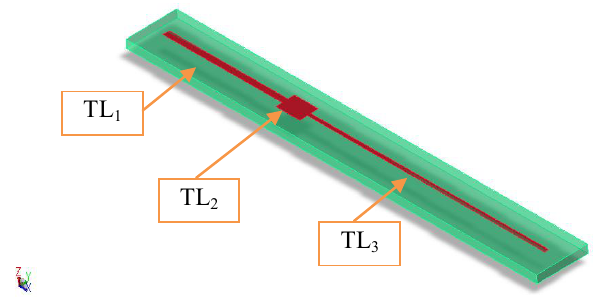
Figure 10: Microstrip lines in cascade understudy.